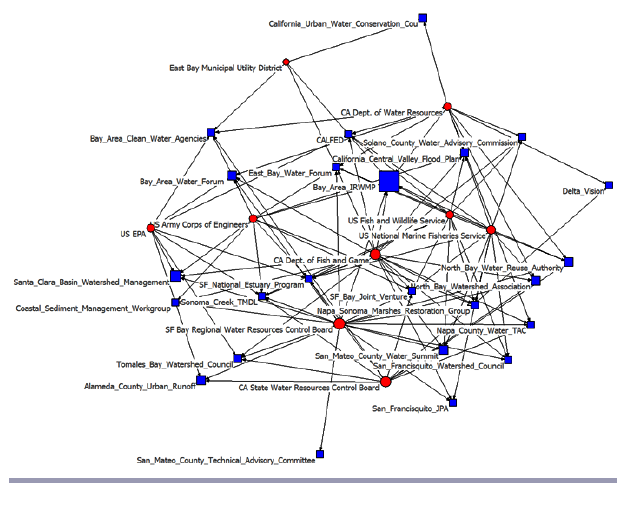
Fig. 3 . Most central actors and institutions in the Bay Area ecology of games.